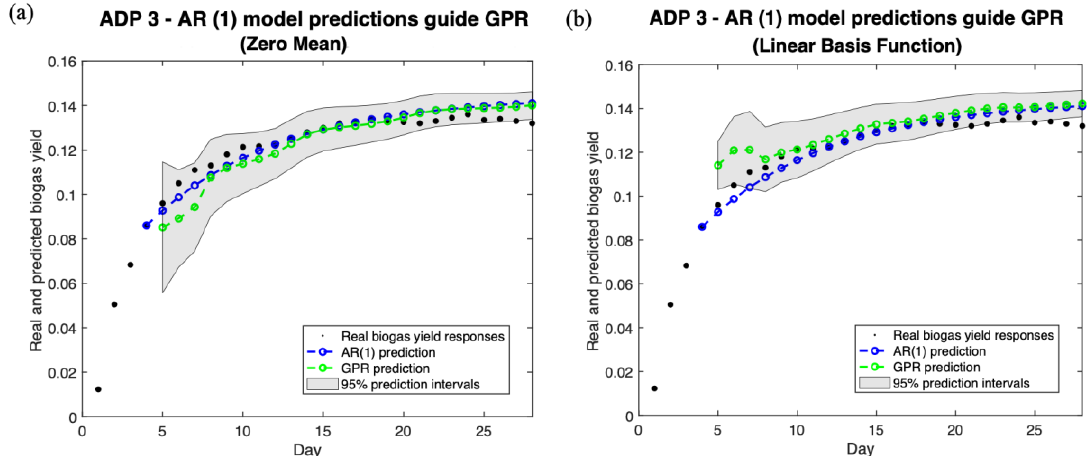
Figure 3. The prediction and its probability distribution of the GRP guided by the prediction of the inferred AR (1) model. ( a ) Zero mean and squared exponential kernel. ( b ) Linear basis function and squared exponential kernel.